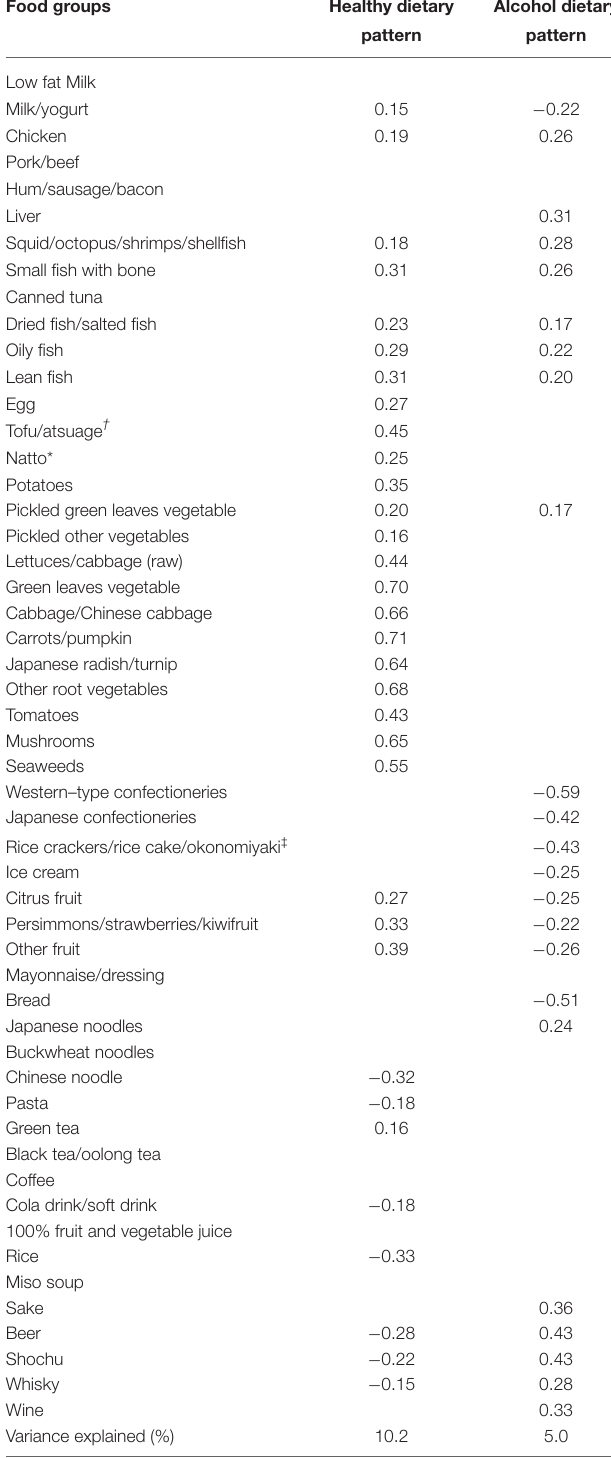
TABLE 1 | Factor loading matrix for dietary patterns identified by the principal component